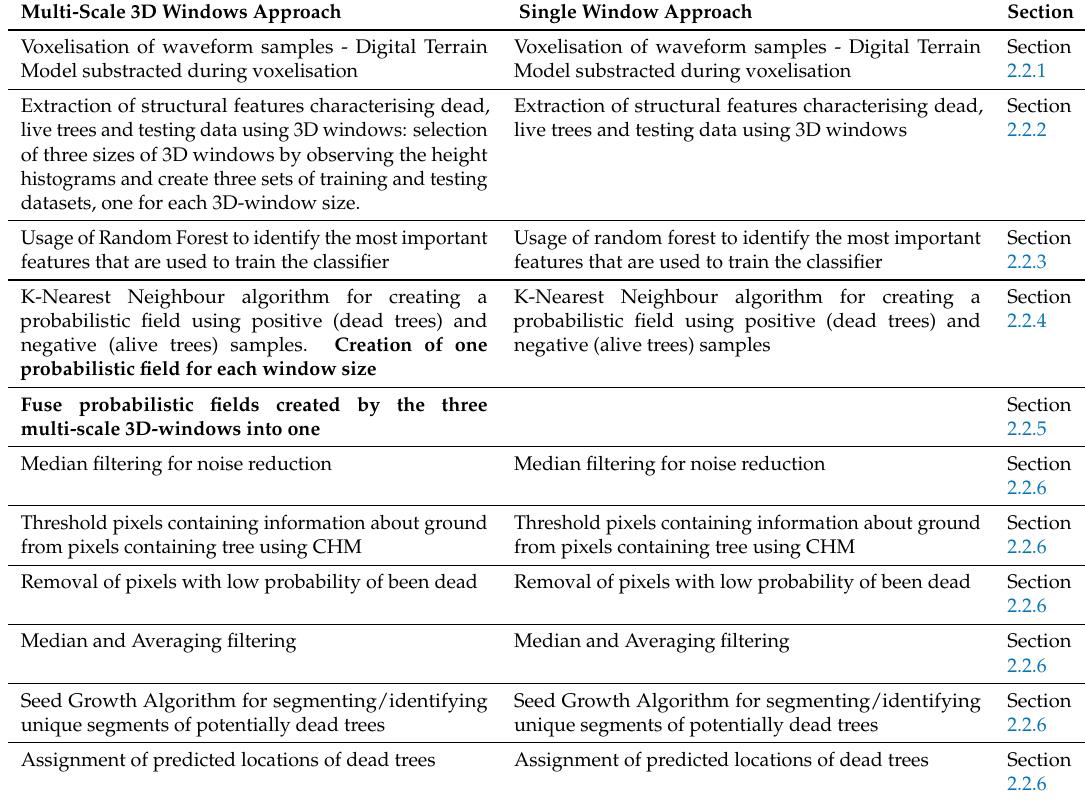
Table 1. List of processing step with associated